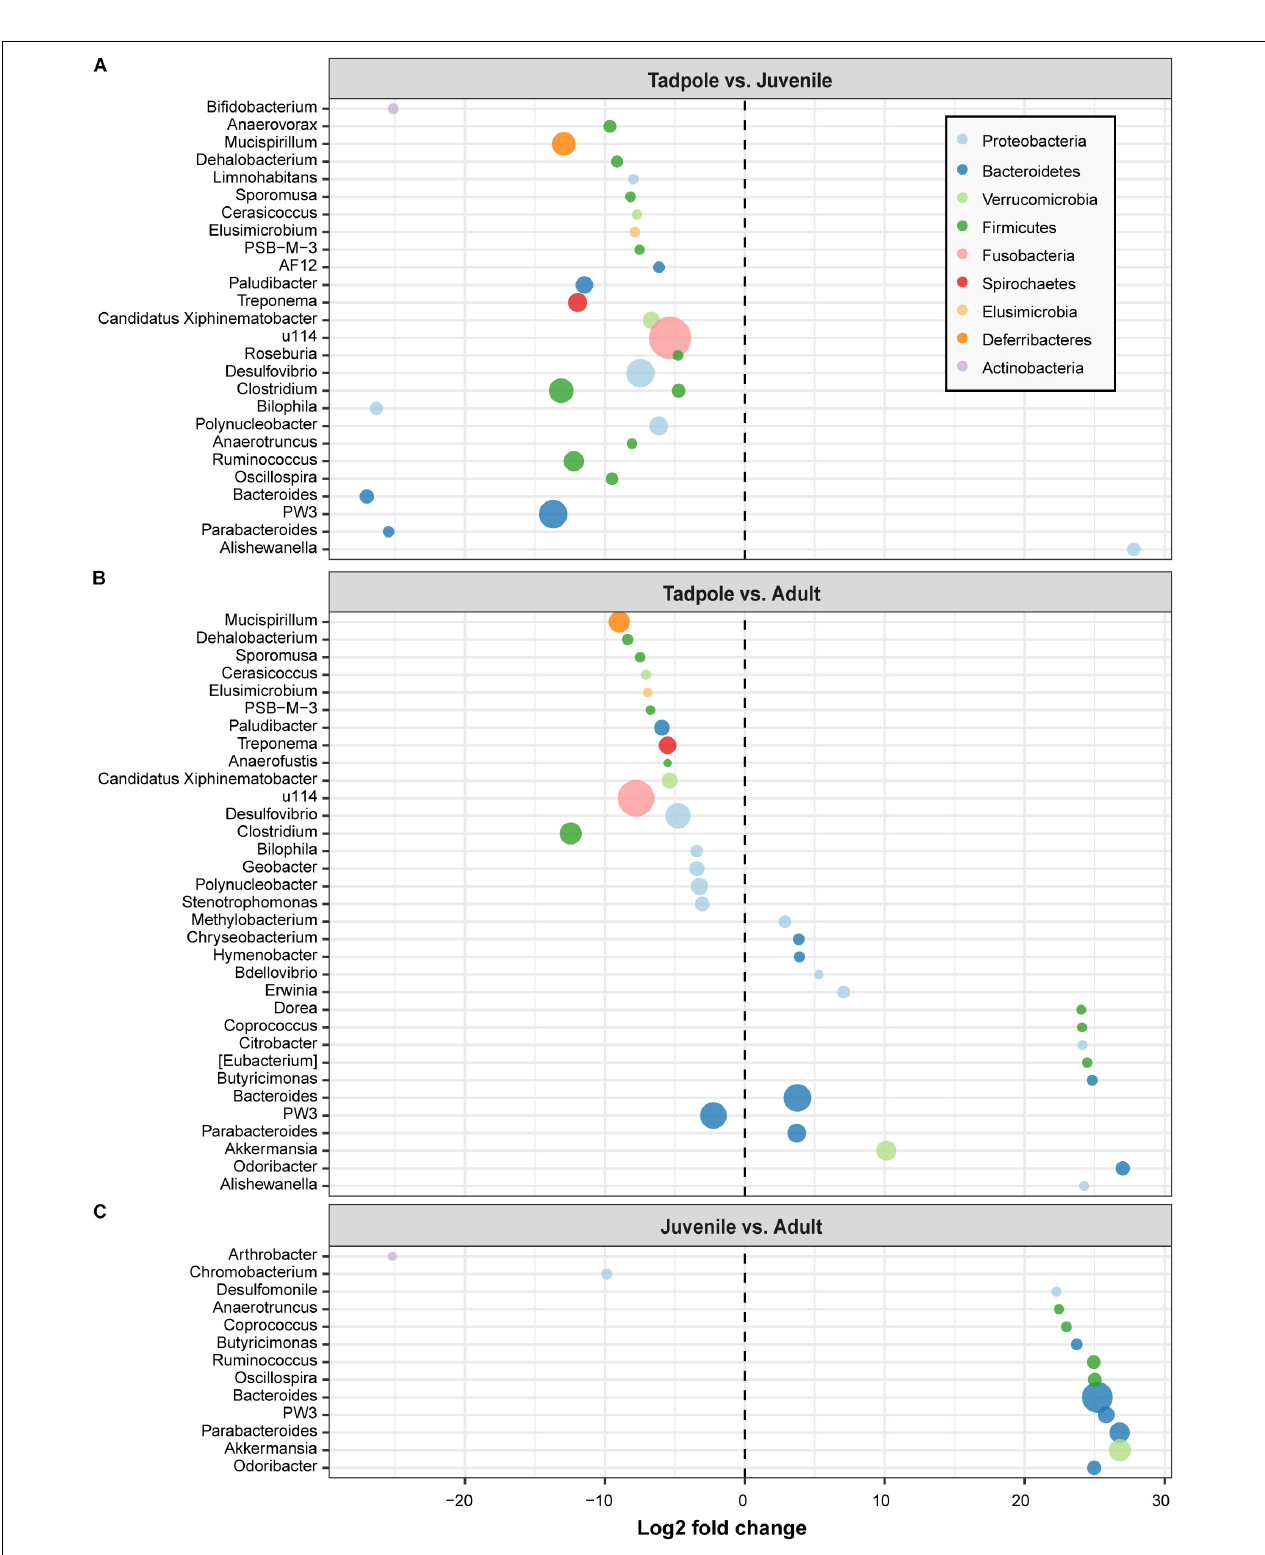
FIGURE 6 | Fold changes of identified bacterial genera (circles) that differed between life stages. (A) Tadpole vs. juvenile, (B) Tadpole vs. adult, and (C) Juvenile vs. adult. Bacterial genera with a log2 fold change less than 0 were more abundant in the life stage indicated on the left, whereas those with a log2 fold change higher than 0 were more abundant in the indicated life stage on the right. Bacterial genera are colored by phylum and sized by mean relative abundance across samples.